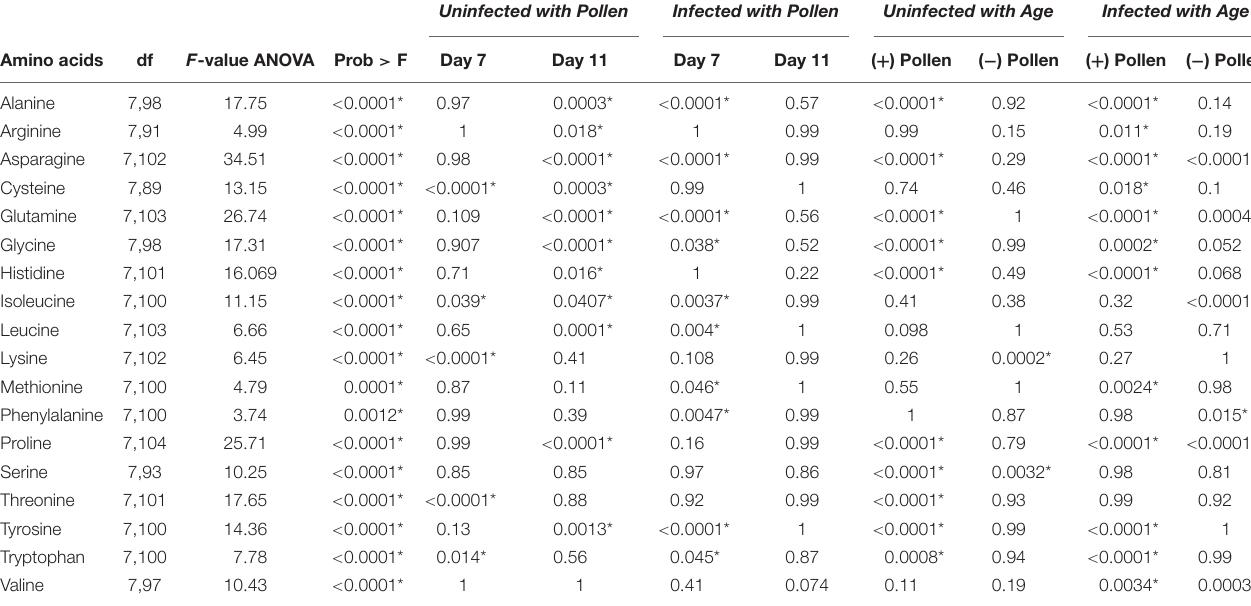
TABLE 2 | Statistical values with pollen and age in bees ± infection. Uninfected with Pollen Infected with Pollen Uninfected with Age Infected with Age